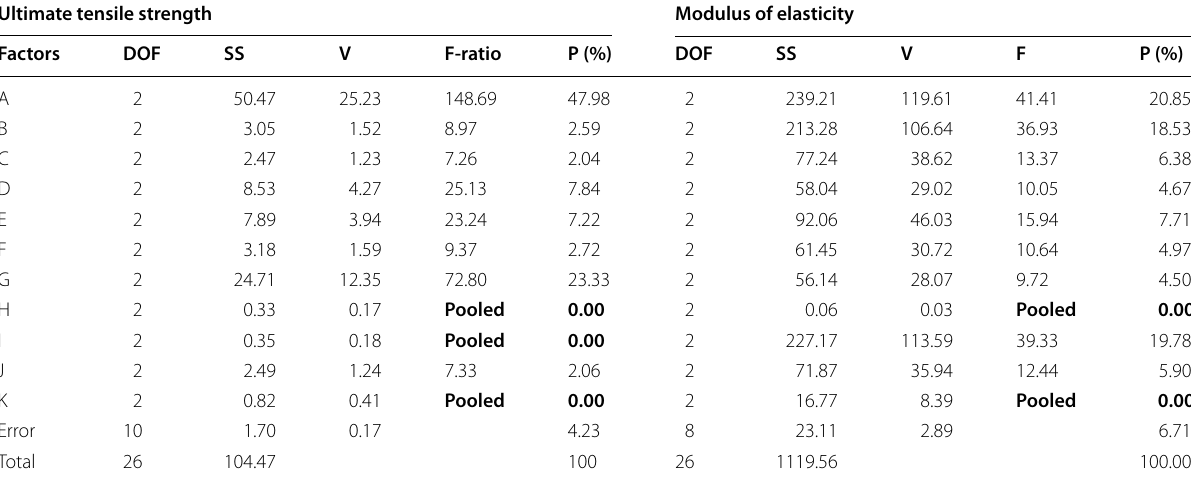
Table 3 Pooled ANOVA for tensile strength and modulus of